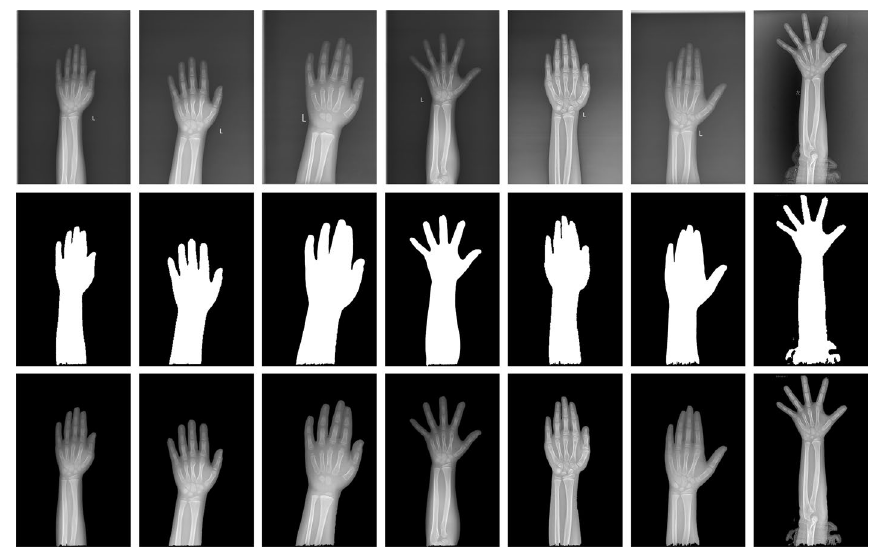
Fig. 7 Hand segmentation result based on U-Net